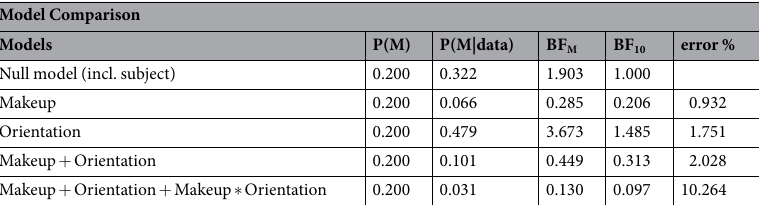
Table 1. Model comparison output for the results of Experiment 1. Note . All models include